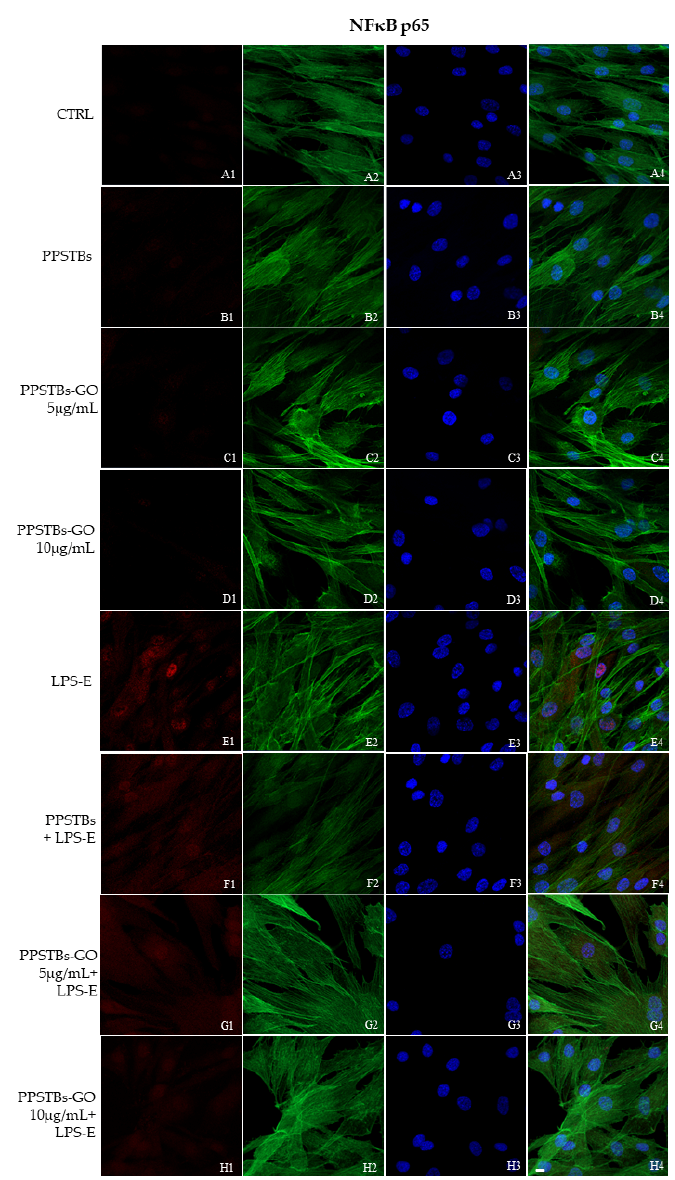
Figure 7. NF κ B p65 signaling pathway in hGFs cell line. Expression of NF κ B analyzed by confocal microscopy ( A1 – H4 ), NF κ B p65 expression in untreated cells (CTRL), in hGFs cultured with PPSTBs, in hGFs cultured with PPSTBs enriched with GO at 5 μ g/mL, in hGFs cultured with